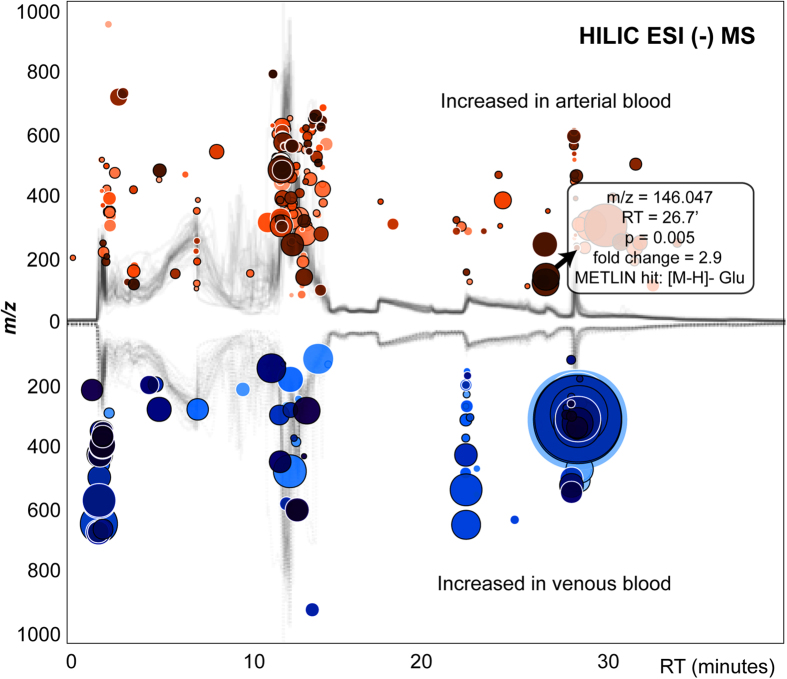
Cloud plot showing metabolite features (represented by “bubbles”) whose levels vary significantly between arterial and venous blood (p < 0.01, Int > 10,000, median fold change > 1.3).The fold change is used as radius scale of each bubble. Darker color (in red and/or in blue tones) of the bubble indicates lower p-value.